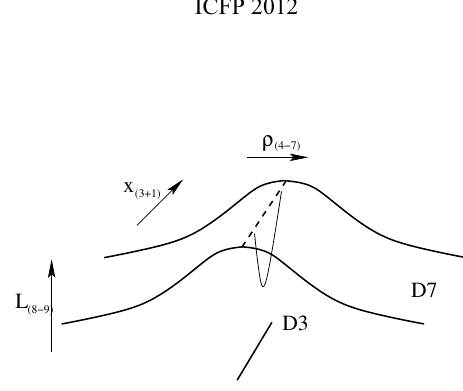
Figure 2. Schematic of a chiral symmetry breaking D3 / D7